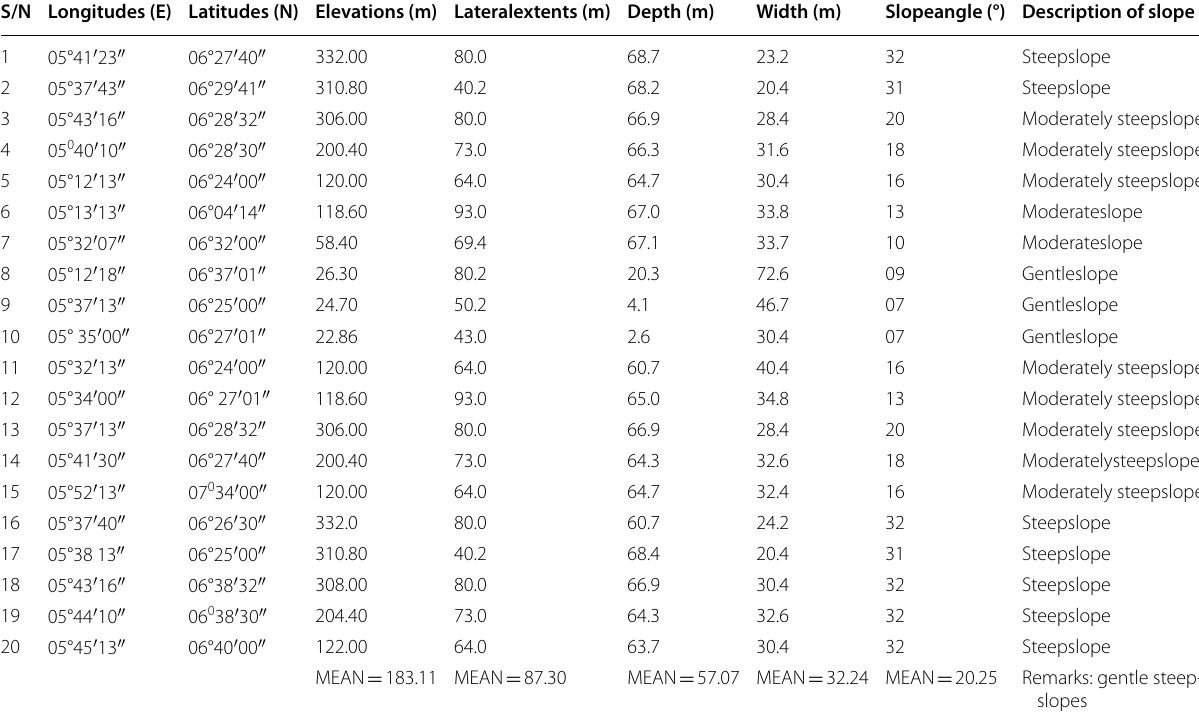
Table 1 Field measurements for gullies and slides in the study area S/N Longitudes (E) Latitudes (N) Elevations (m) Lateralextents (m) Depth (m)